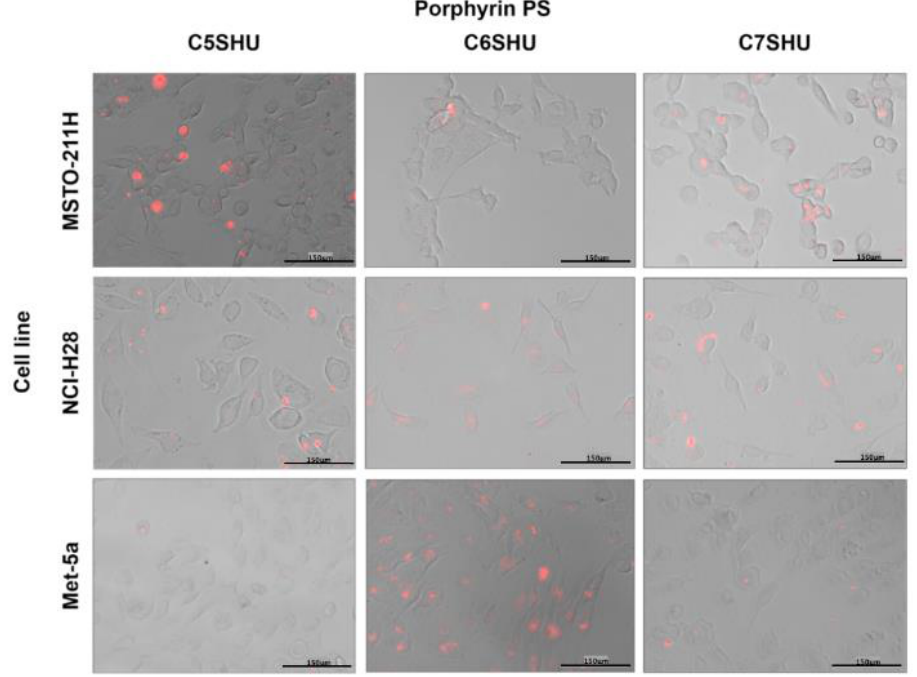
Figure 3. Example of cellular localization. The MSTO-211H, NCI-H28, and Met-5a cell lines were treated with PS C5SHU, C6SHU and C7SHU at concentrations of 15 or 20 μg/mL dependent on EC 50 for 24 h. Images present are composite images of the bright field image and the Texas red channel. Scale bar: 150 µm .